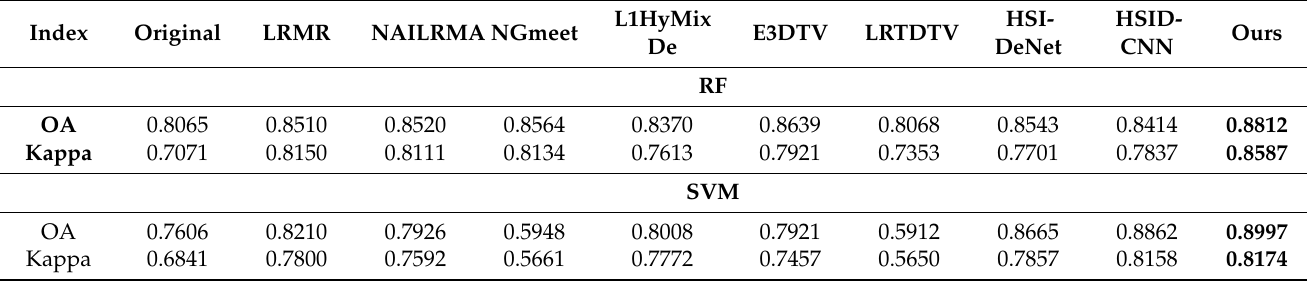
Table 5. Classification accuracy results for Indian Pines.